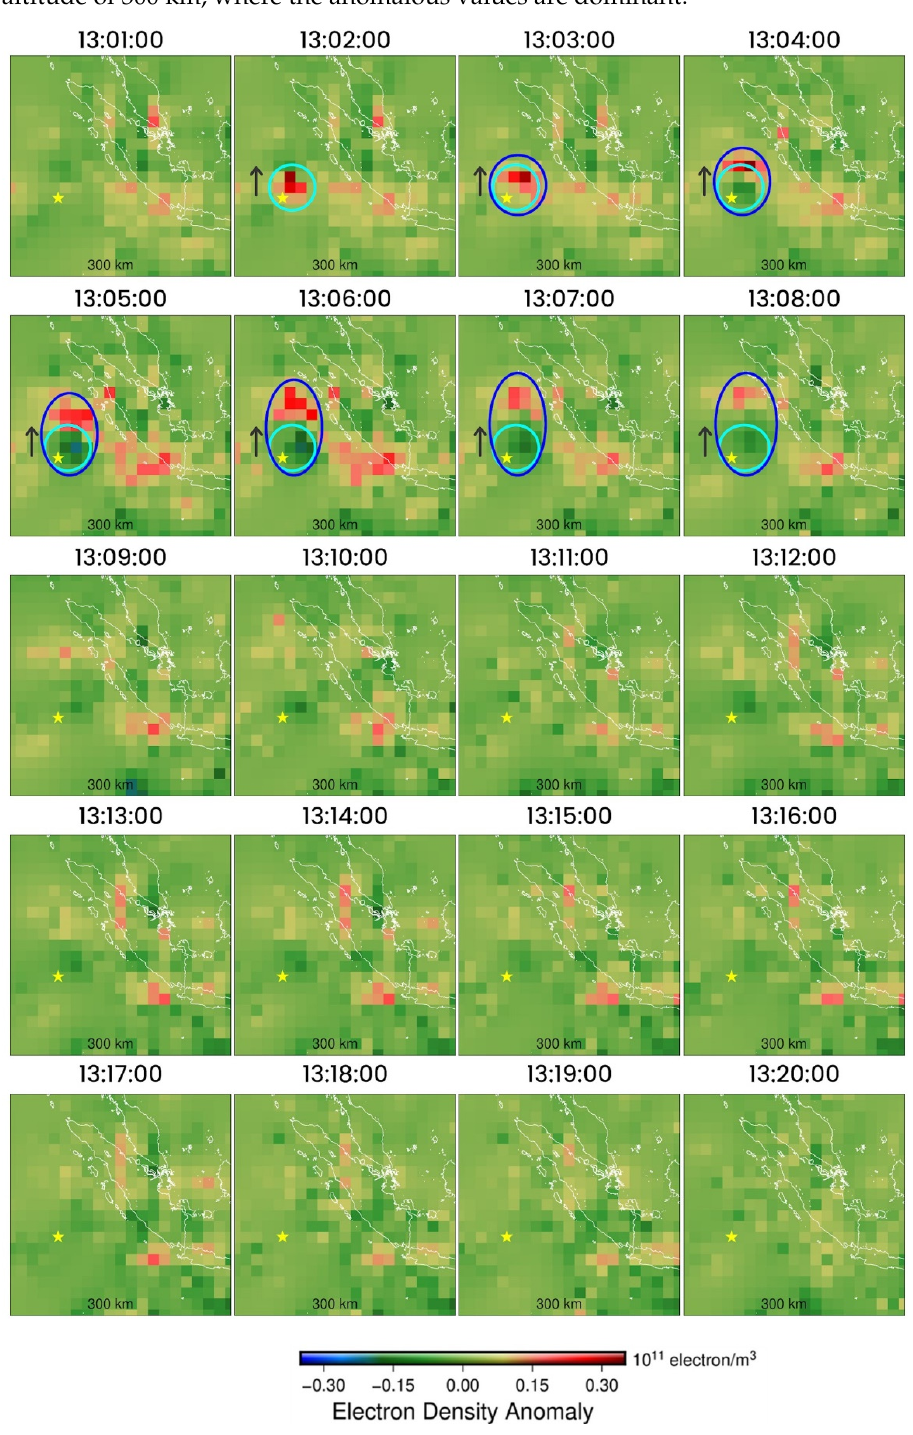
Figure 8. Tomography results of the 2016 West Sumatra Earthquake at an altitude of 300 km. The yellow star is the epicenter. The light blue indicates the beginning of the emergence of CID and followed by the dark blue circle and the black arrow indicate the direction and area of movement the positive CID. The positive anomaly starts to increase at 13.02 UT.